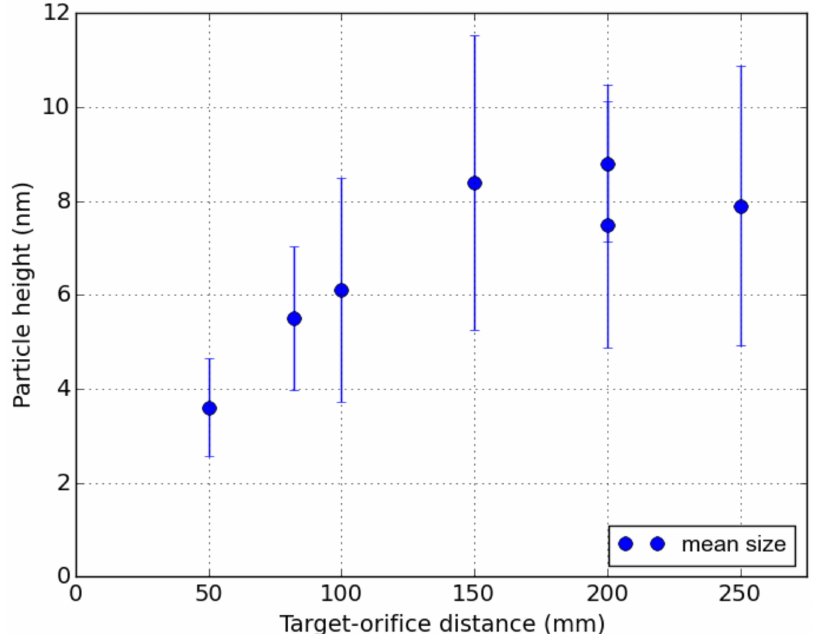
Figure 3. The mean height of nanoparticles versus the target–orifice distance. Error bars represent the FWHM of the size distribution.